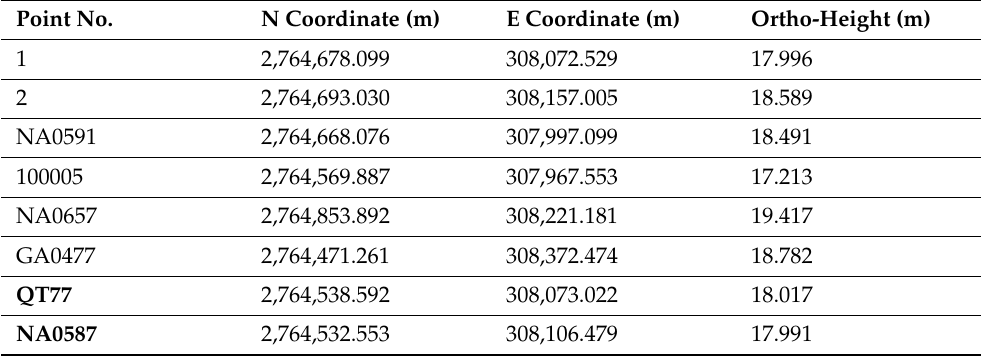
Table 10. The cadastral TWD97 coordinates and ortho-height of used control points. Point No.